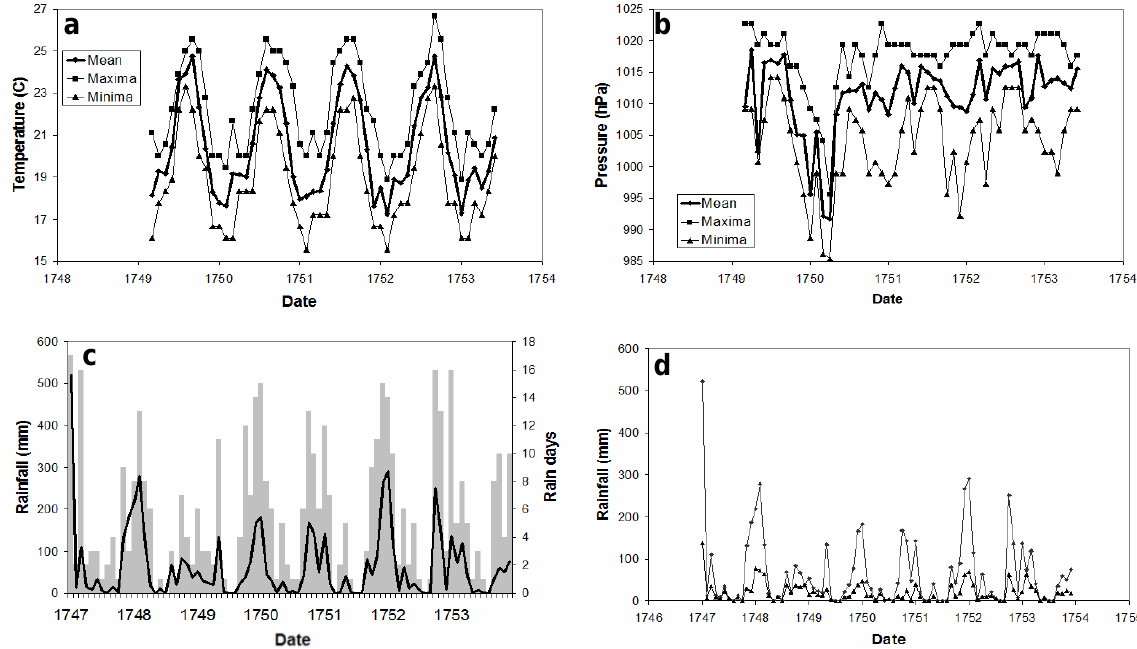
Fig. 3. Meteorological parameters recorded in Funchal by Heberden from March 1749 to June 1753 (temperature and pressure) and from January 1747 to December 1753 (rainfall). (a) Monthly temperature values. (b) Monthly pressure values. (c) Monthly rainfall (dark line) and number of rainy days (grey bars). (d) Monthly rainfall (grey line) and largest daily amount of rain per month (dark line).